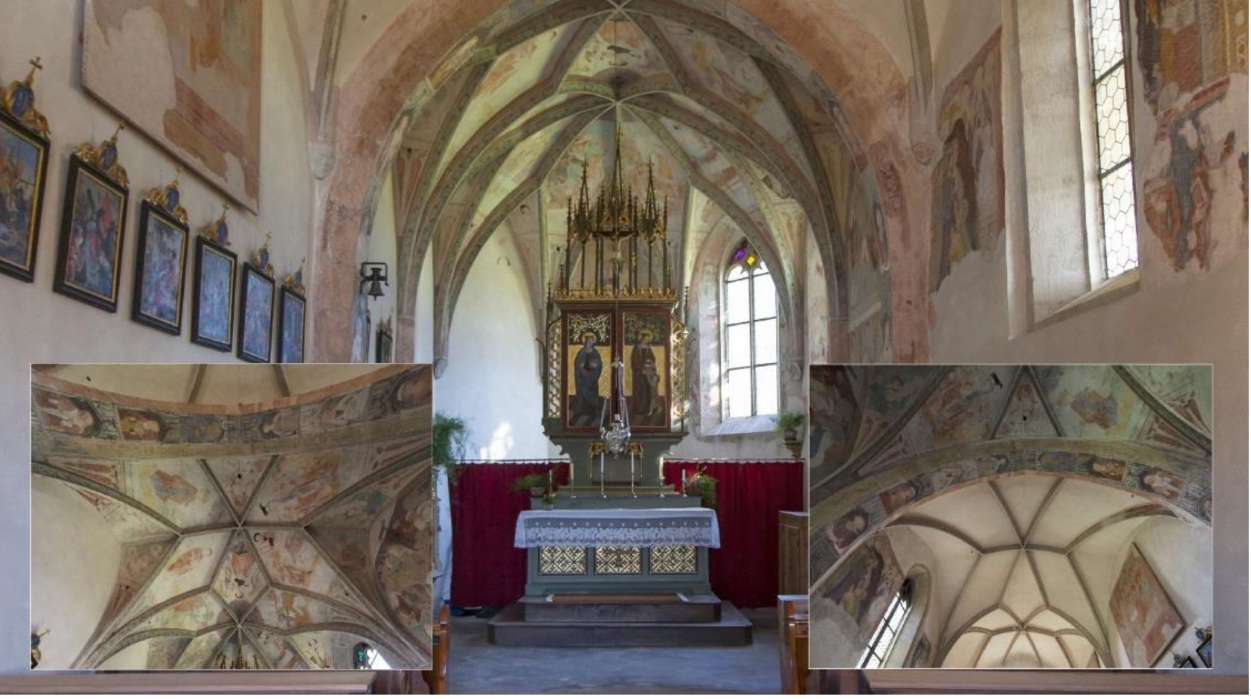
Figure 3. The vaulted system of the church. Source: F.